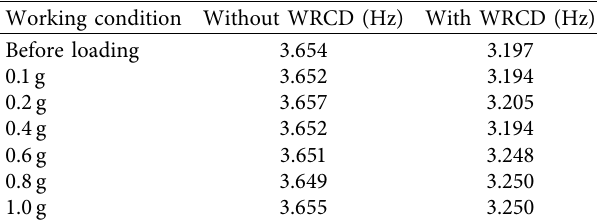
Figure 11: Maximum acceleration of pier top under El Centro input. Table 4: Natural frequency of the two-test model.